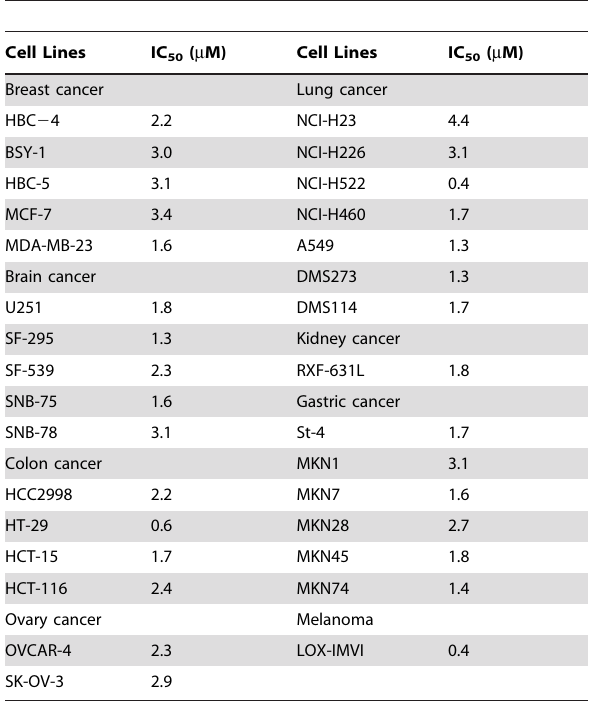
Table 2. IC 50 values ( m M) of Q15 for inhibiting proliferation of different human tumor cell